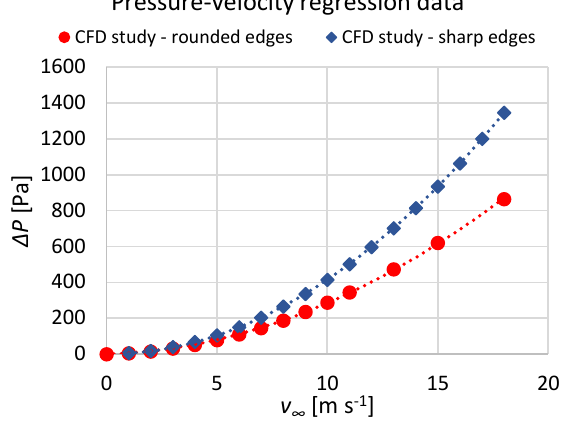
Fig. 5. Pressure drop Δ𝑃 on mean velocity 𝑣 ∞ for normal air flow through perforated plate with sharp and round edged holes .